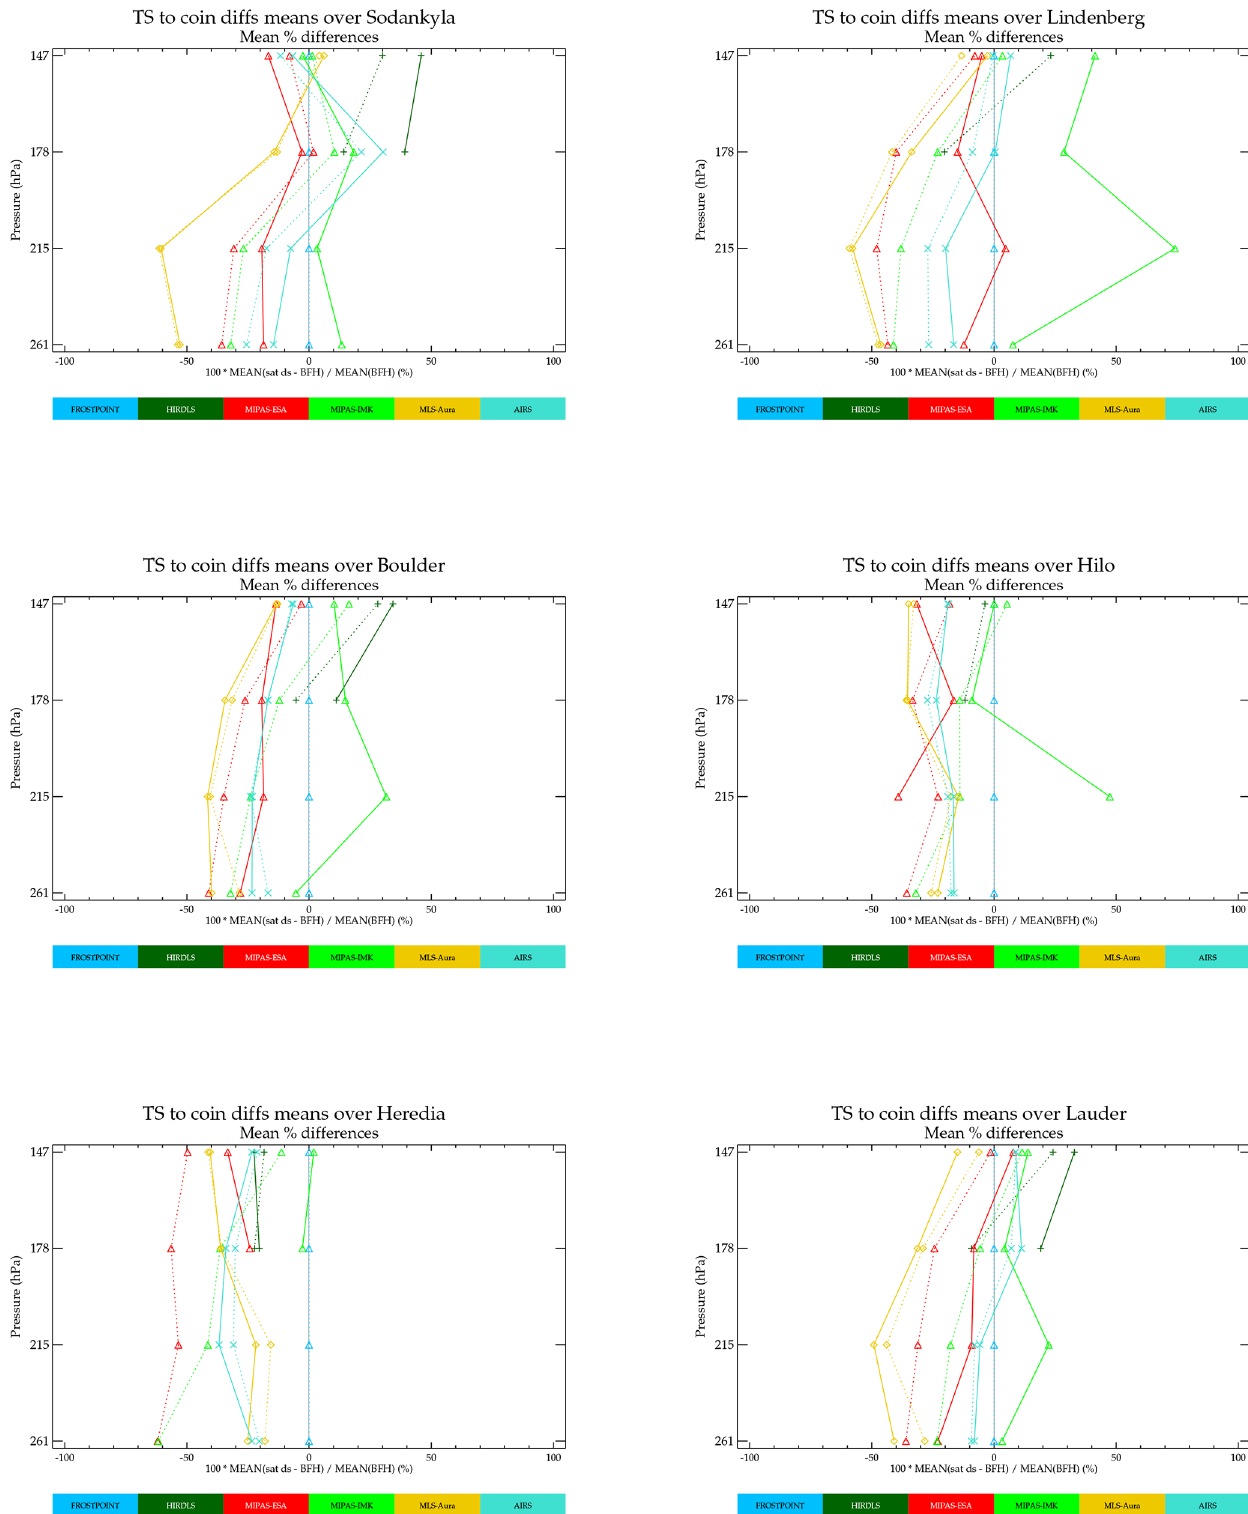
Figure 14. Comparisons of biases computed from direct location and temporal coincidences (solid lines) versus that derived from a time series function using all available data satisfying a positional coincidence criteria